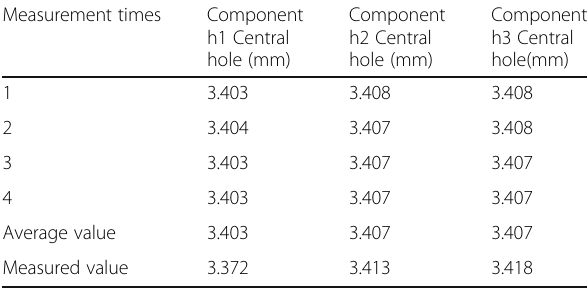
Table 2 Inner diameter of three test components Measurement